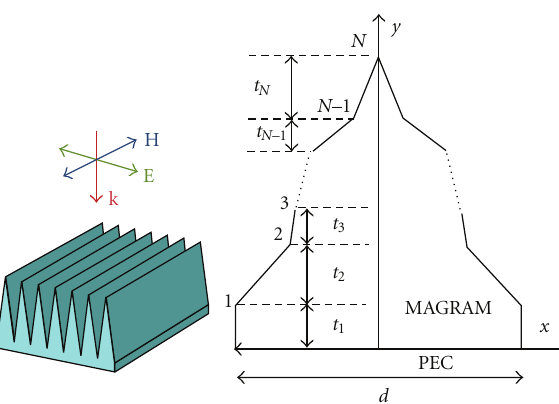
Figure 7: Geometry and design parameters of the electromagnetic absorber.